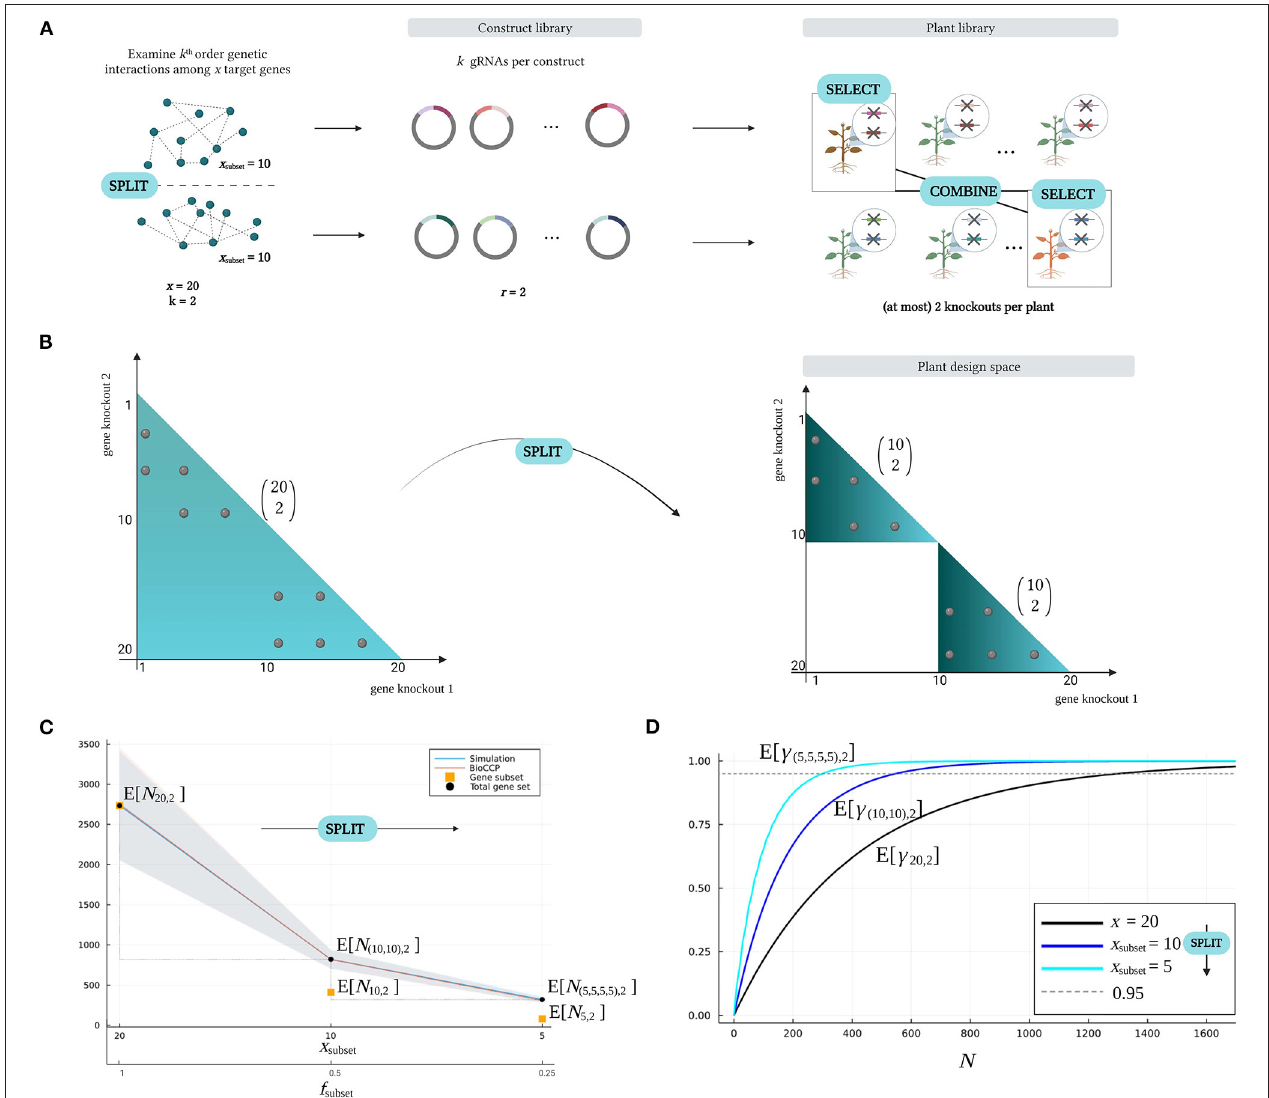
FIGURE 7 | The Split–Select–Combine strategy. (A) The Split–Select–Combine strategy starts with dividing a set of target genes into meaningful subgroups. Here, a total number of x = 20 genes is divided into two subsets, each of size x subset = 10 genes ( Split ). To study genetic interactions within these subsets separately, a construct library is created for each subset. Each construct contains two random gRNAs to explore pairwise genetic interactions ( r = k = 2). Performing a phenotypic screen on the corresponding plant libraries allows to select plants with an interesting phenotype ( Select ), which can be crossed to investigate genetic interactions between the gene subsets ( Combine ). (B) Studying 20 target genes in two subgroups of 10 genes ( Split ) creates a plant design space that consists of two subspaces of the original design space. (C) Impact on the plant library size for full coverage as a total set of x = 20 genes is grouped into subsets of size x subset = 10 or size x subset = 5 ( Split ). The fraction of the total number of genes that is present in the subset is denoted by f subset . The plant library size for full coverage of all pairwise combinations of gene knockouts within the subsets separately is indicated as N 10,2 and N 5,2 (orange squares), respectively. The plant library size for full coverage of the entire gene set, is given by N (10,10),2 and N (5,5,5,5),2 (black dots). (D) Impact on the expected coverage w.r.t. plant library size as a total set of x = 20 genes is grouped into subsets of size x subset = 10 or size x subset = 5 ( Split ). Note that all parameters of the experiment (except for the number of target genes that is varied on the x -axis) are configured with the default settings in Table 2 .